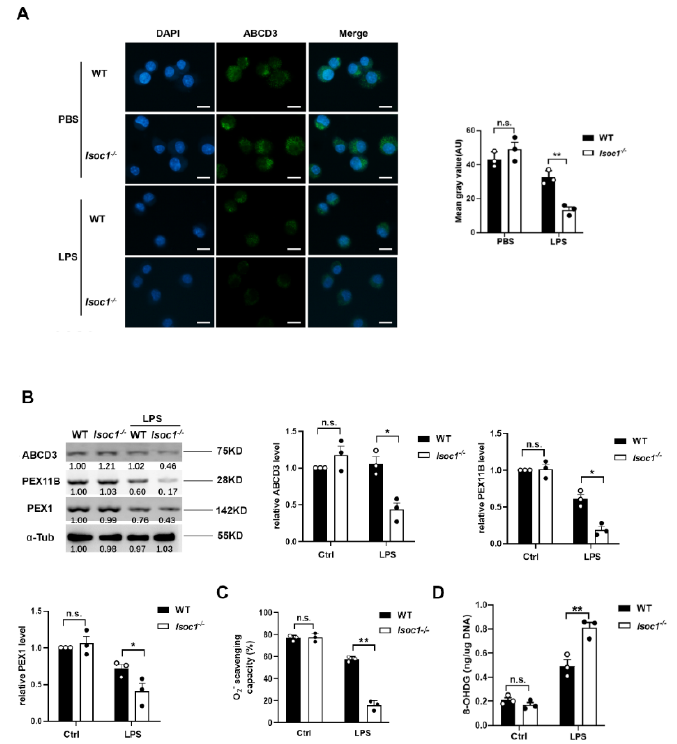
Figure 3. After LPS treatment, peroxisome level decreases more significantly in ISOC1-deficient cells than in wild-type cells. Wild-type or ISOC1-deficient RAW264.7 cells were treated with LPS (300 ng/mL) for 24 h. ( A ) Peroxisomes were labeled with ABCD3 and were observed with fluorescence microscopy. Scale bar = 10 µ m. Mean gray values were analyzed by Image J v1.51 (Wayne Rasband, Bethesda, MD, USA). ( B ) Cell lysates were subjected to WB with antibodies to ABCD3, PEX11B, and PEX1. ( C ) O2—scavenging capacity was measured using a superoxide anion scavenging